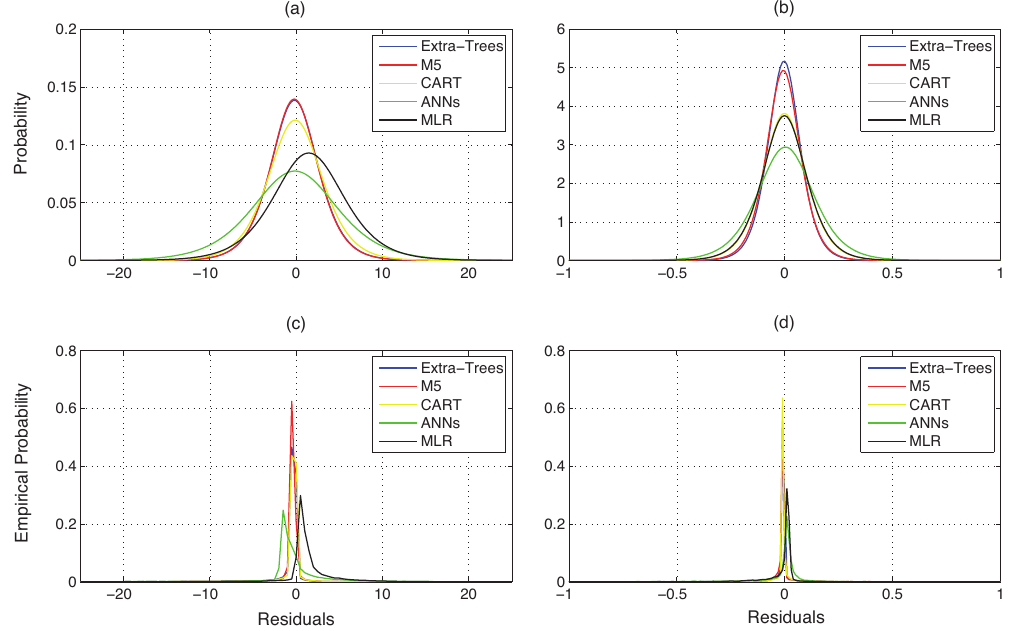
Fig. 8. Fitted logistic and empirical probability distribution of the models residuals for Marina catchment (a, c) and Canning River (b, d) on the testing